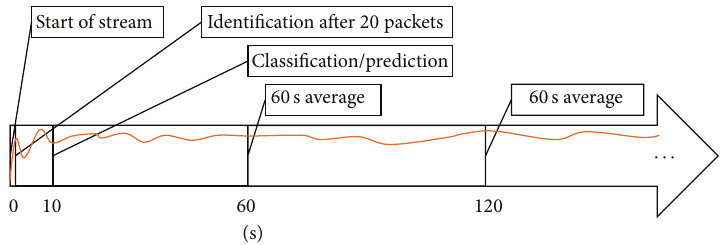
Figure 2: Bandwidth prediction procedure timeline.